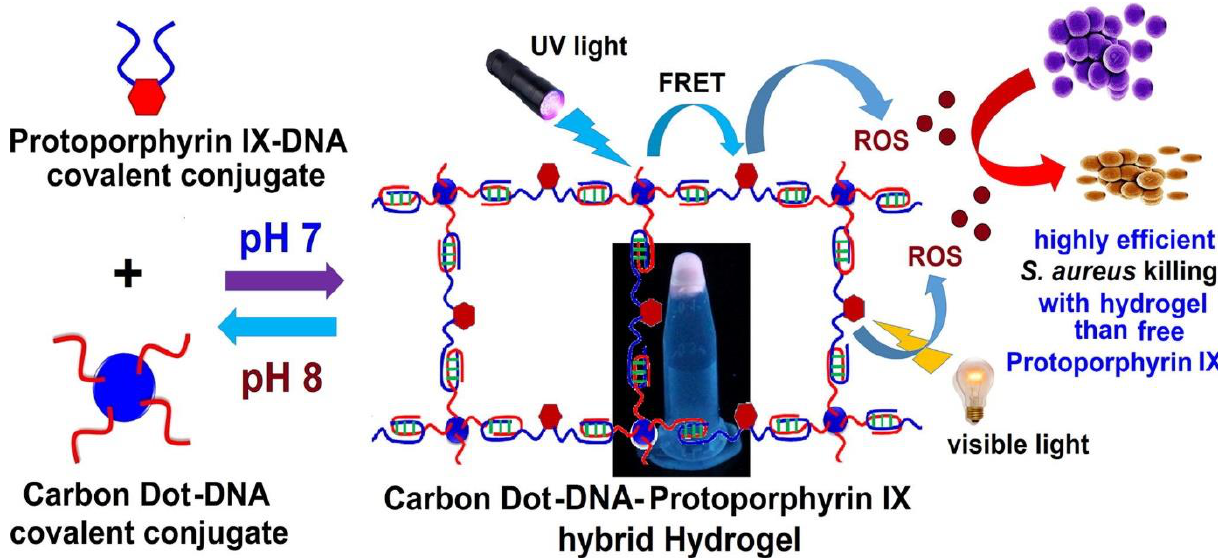
Figure 23. DNA-carbon dot–protoporphyrin IX hybrid hydrogel formation and its antibacterial photodynamic therapy applications. Reprinted with permission. Copyright 2019, Elsevier [93].